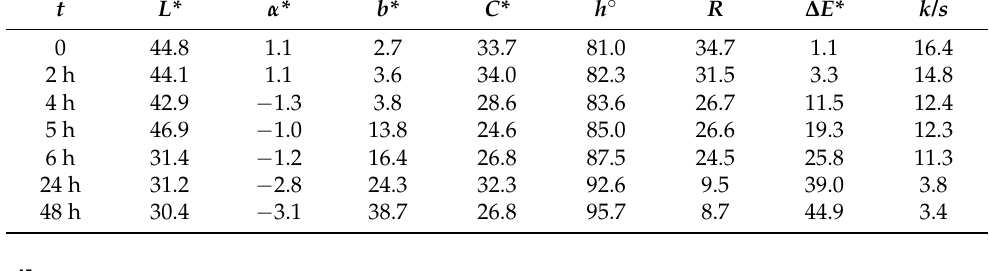
Table 2. Recordings and estimations of colorimetric parameters over several UV irradiation time intervals.